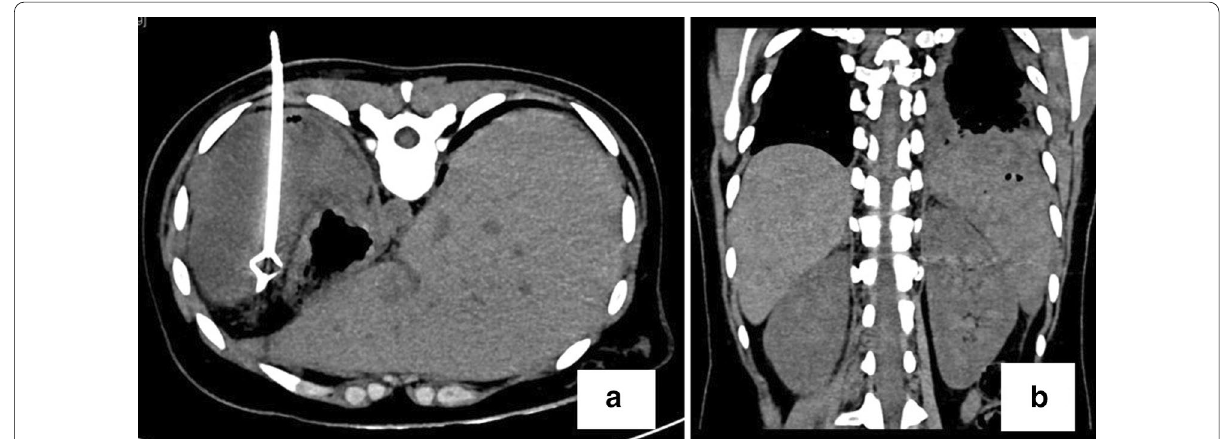
Fig. 5 CT axial ( a ) image showing malecot catheter placement within the splenic abscess; CT coronal ( b ) image showing drained-out splenic